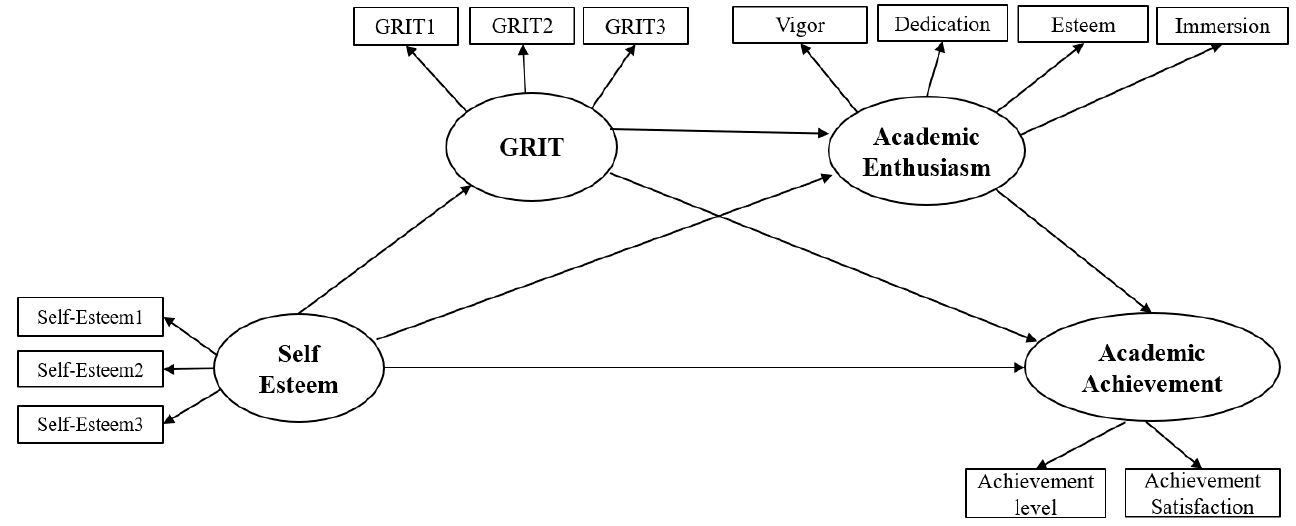
Figure 3. Partial mediation model.